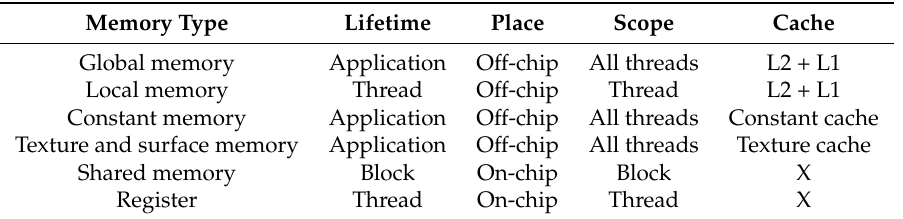
Table 3. Memory types in